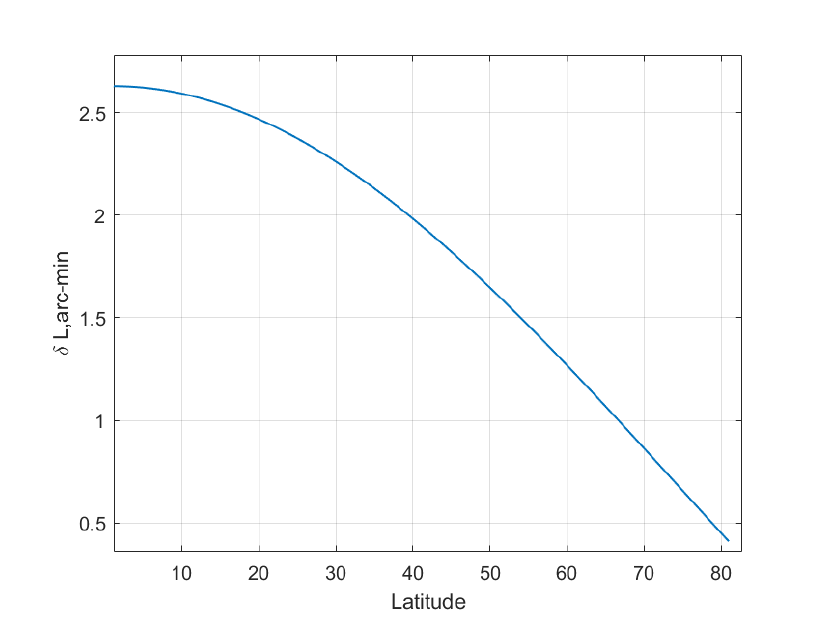
Figure 9. The latitude error of the analytic method 2 with latitude